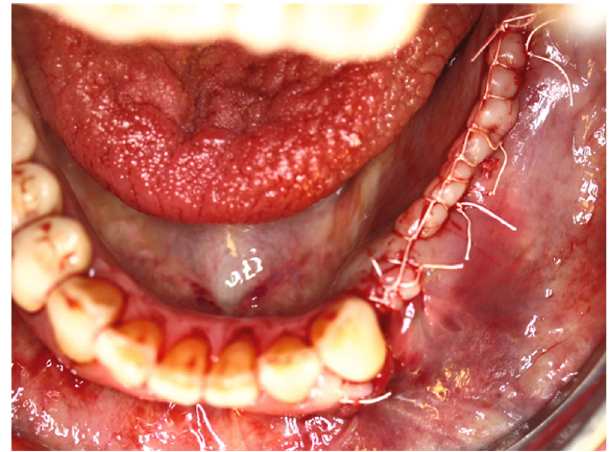
Figure 10: YxOss CBR® titanium mesh fi lled with the bone replacement graft.